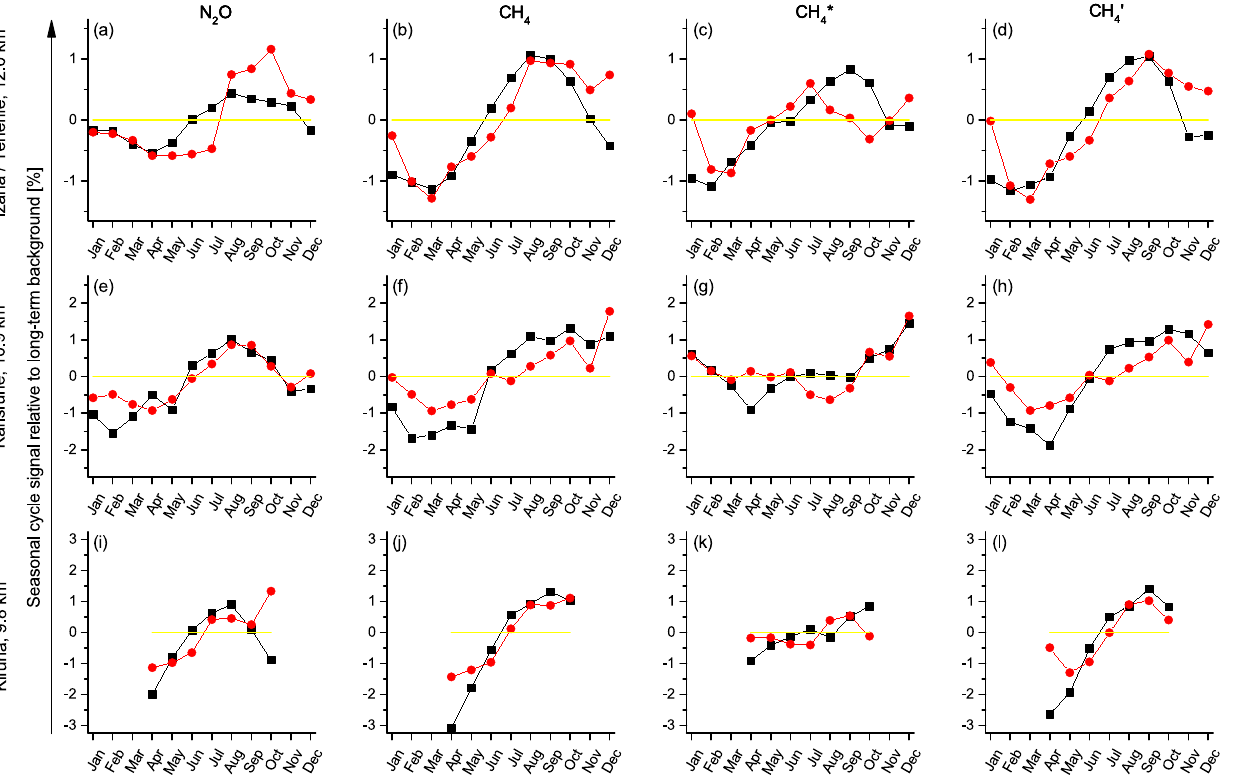
Figure 15. Same as Fig. 14, but for the seasonal cycles at altitudes representing the UTLS